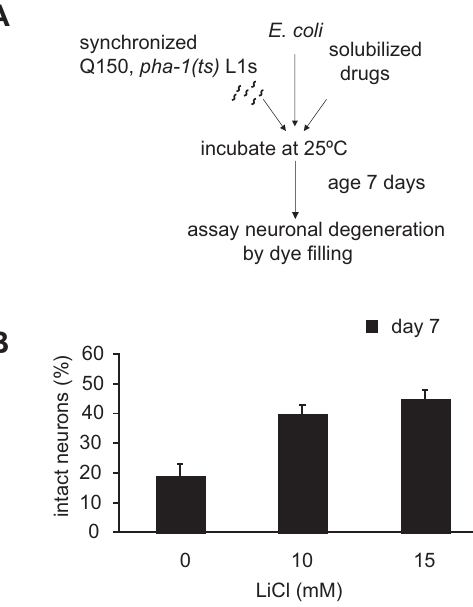
Figure 3. Compounds decrease polyQ toxicity in a pqe-1indepen- dent manner in aged animals. (A) Flow diagram of the aging assay. 30 synchronized pha-1;Htn-Q150 L1s per well were incubated at 25 u C in S medium with E. coli at an OD (A 595 ) of 0.5 with varying concentrations of compound to a total volume of 1 ml. On day 7, animals were collected and dye filled using DiD. (B) LiCl increased ASH neuron survival in the pha-1;Htn-Q150 aged animals. ASH neurodegeneration was evaluated by the presence or absence of dye-filled ASH neurons on day 7. 50 neurons were scored for each trial; mean percentage of 3 different trials 6 SD is shown. p=0.0033 for 15 mM